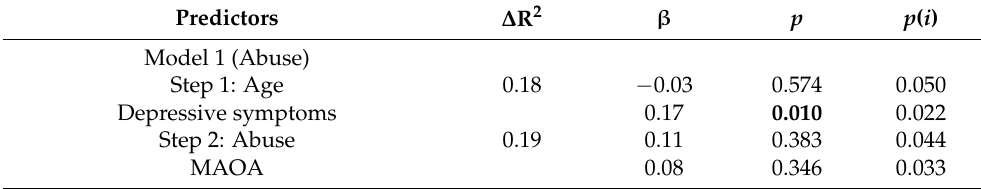
Table 2. Male adolescents’ nonsuicidal self-injury (NSSI) regressed on MAOA T941G and COMT Val158Met in interaction with childhood abuse and